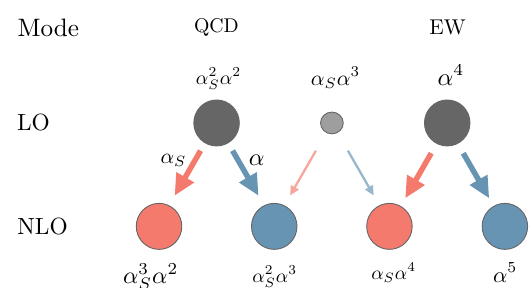
Figure 1. Tower of perturbative contributions to V + 2 jet production at LO and NLO considered and evaluated in this study. In the presented counting the O ( α ) vector-boson decays are